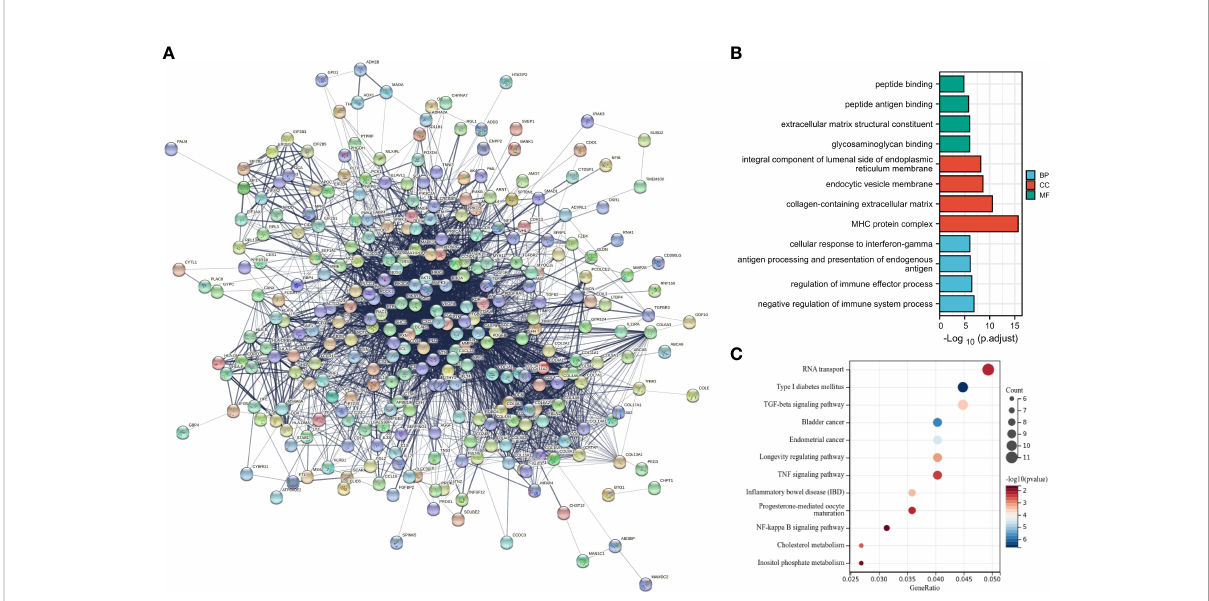
FIGURE 4 Construction of DFU-related gene network and screening of key pathway. (A) , PPI network of DFU related genes. (B) , GO function analysis of candidate genes at the biological process, cellular component and molecular function levels. (C) , KEGG pathway enrichment analysis of candidate